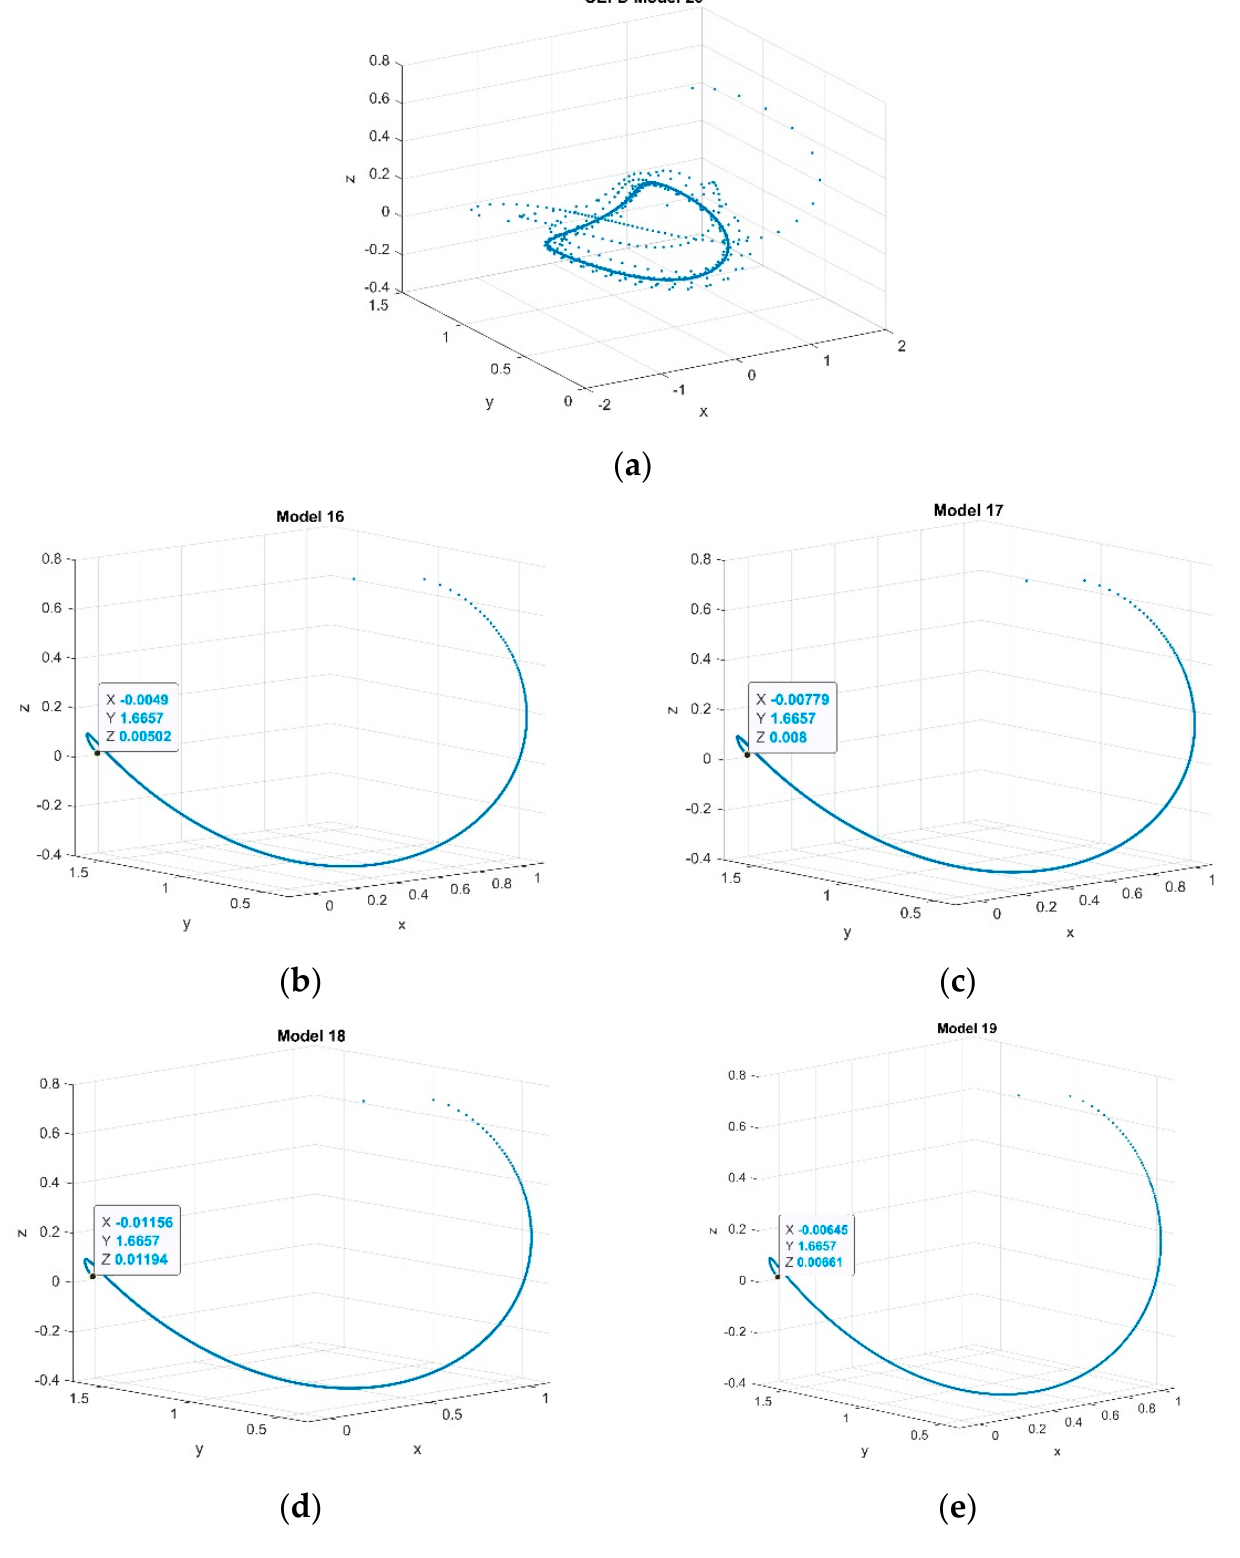
Figure 1. Phase portraits ( a ) CEFD model (20) ( b ) MCEFD Model (16) ( c ) Model 17 ( d ) Model 18 ( e ) Model (19).